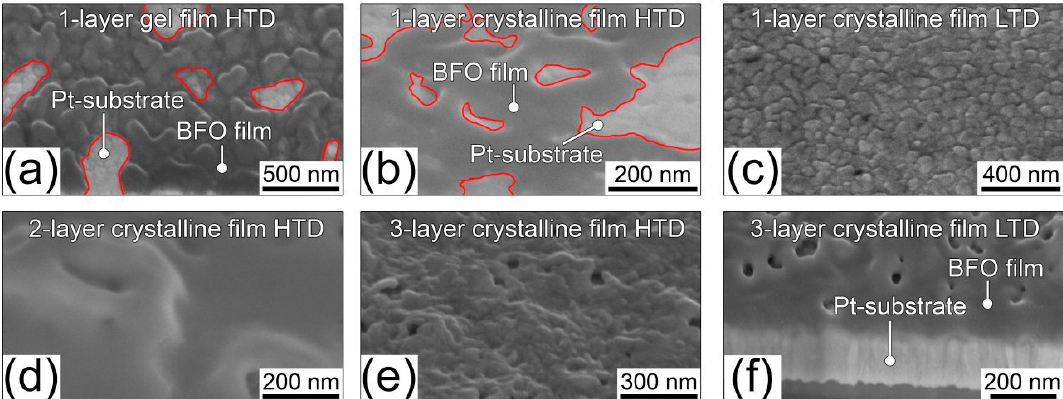
Figure 2. In-lens SEM images of BFO thin films: ( a ) HTD one-layer gel film, ( b ) HTD one-layer crystalline film, ( c ) LTD one-layer crystalline film, ( d ) HTD two-layer crystalline film, and ( e ) HTD three-layer crystalline film. ( f ) Cross-section of the HTD three-layer crystalline film done by focused ion beam etching. Red line depicts boundary of the BFO “islands”.